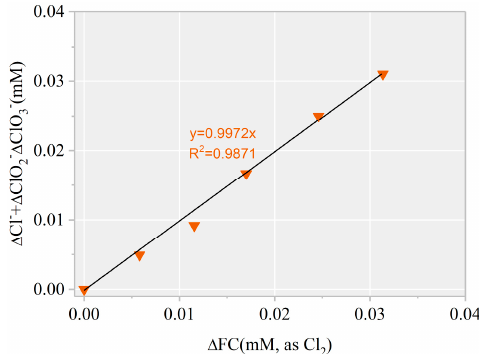
ClO ] + ∆ [ − ClO ] versus ∆ [FC] during AHTN degradation by UV/FC ([AHTN] 0 Figure 7. ∆ [Cl − ] + ∆ [ClO − Figure 7. ∆ [ − Cl ] + ∆ [ − ] + ∆ [ClO − ] versus ∆ [FC] during AHTN degradation by UV/FC ([AHTN] 0 2 3 2 3 = 1.0 mg · L − 1 ; [FC] 0 = 3.28 mg · L − 1 ; pH = 7.0; and 25 ± 1 ◦ C). = 1.0 mg  L − 1 ; [FC] 0 = 3.28 mg  L − 1 ; pH = 7.0; and 25 ± 1 °C).